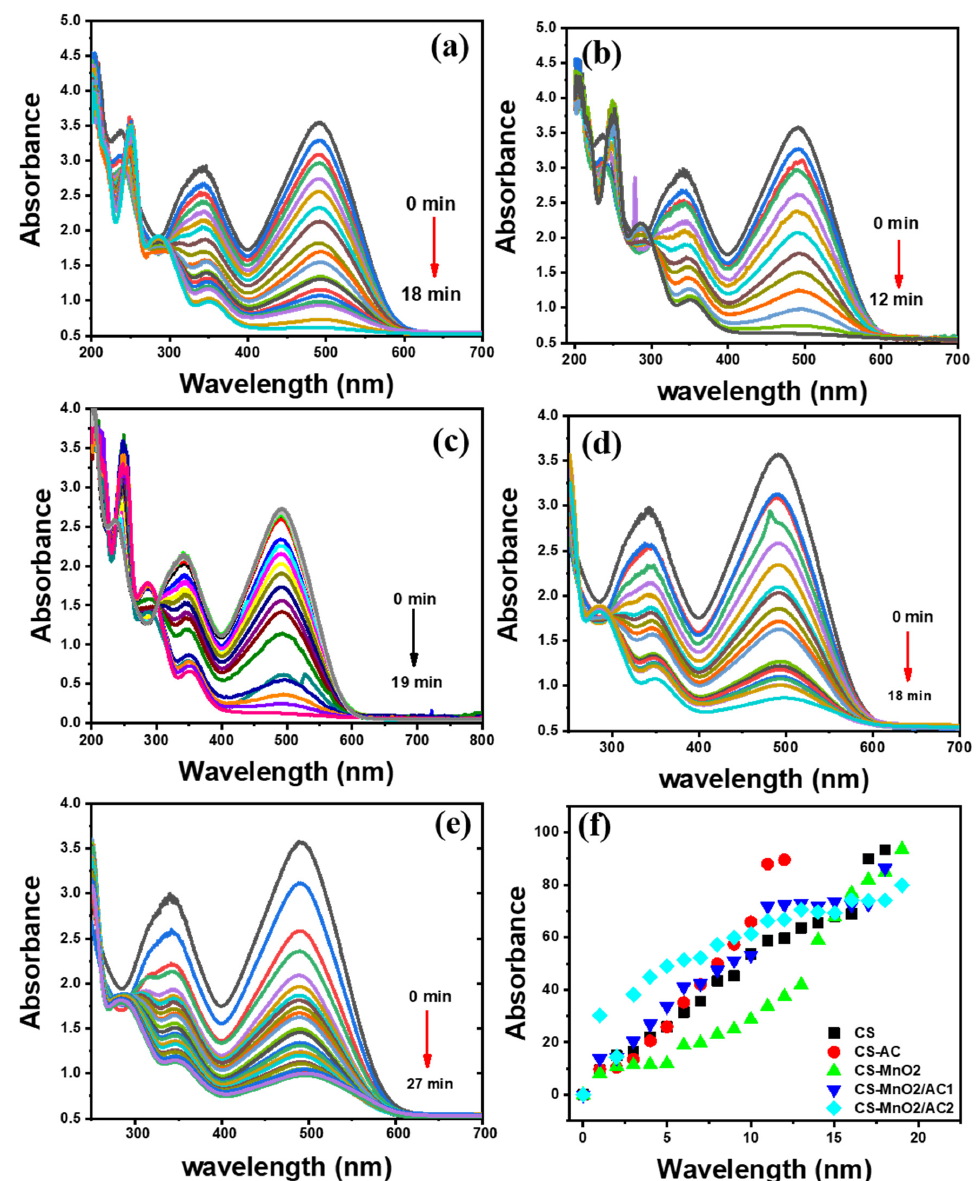
Figure 6. Absorbance spectra of CR degradation in the presence of NaBH 4 by using CS@Co ( a ), CS-AC@Co ( b ), CS-MnO 2 @Co ( c ), CS-MnO 2 /AC1@Co ( d ) and CS-MnO 2 /AC2@Co NPs ( e ), and % degradation of CR dye ( f ). Experimental conditions: 2.5 mL of 0.1 mM CR solution; 0.5 mL of 0.5 mM NaBH 4 solution and 20 mg of each catalyst.